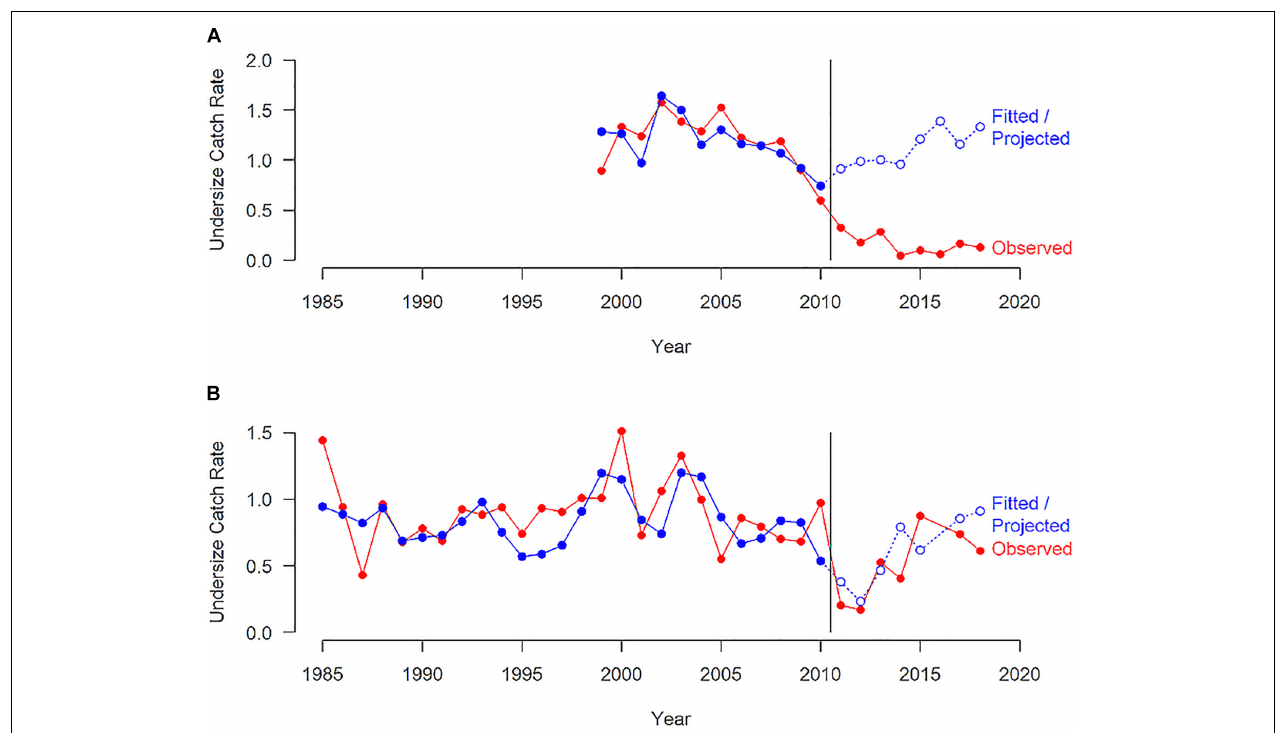
FIGURE 11 | The observed undersize catch rate from a commercial monitoring (number per pot lift) for western rock lobsters in the (A) Kalbarri and (B) Jurien region and the fitted undersize catch rate based on the relationship between undersize and puerulus settlement 3-4 years for the period prior to the heatwave and the projected undersize catch rates post heatwave. The vertical line indicates the occurrence of the